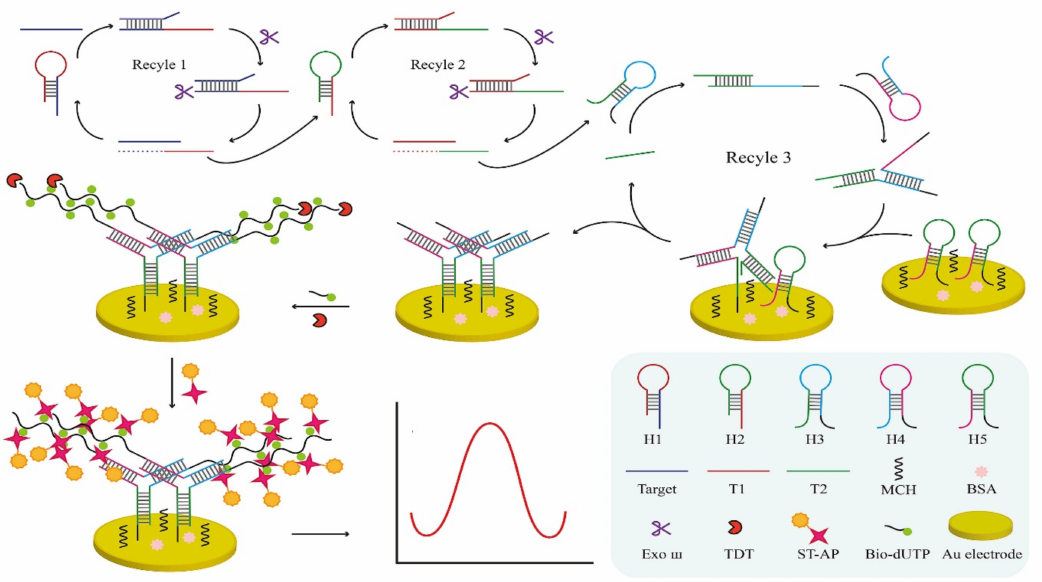
Figure 10. Working mechanism of electrochemical biosensor for the determination of DNA and amplified electrochemical signal quantified by DPV. Reprinted with permission from [87]. Copyright 2019